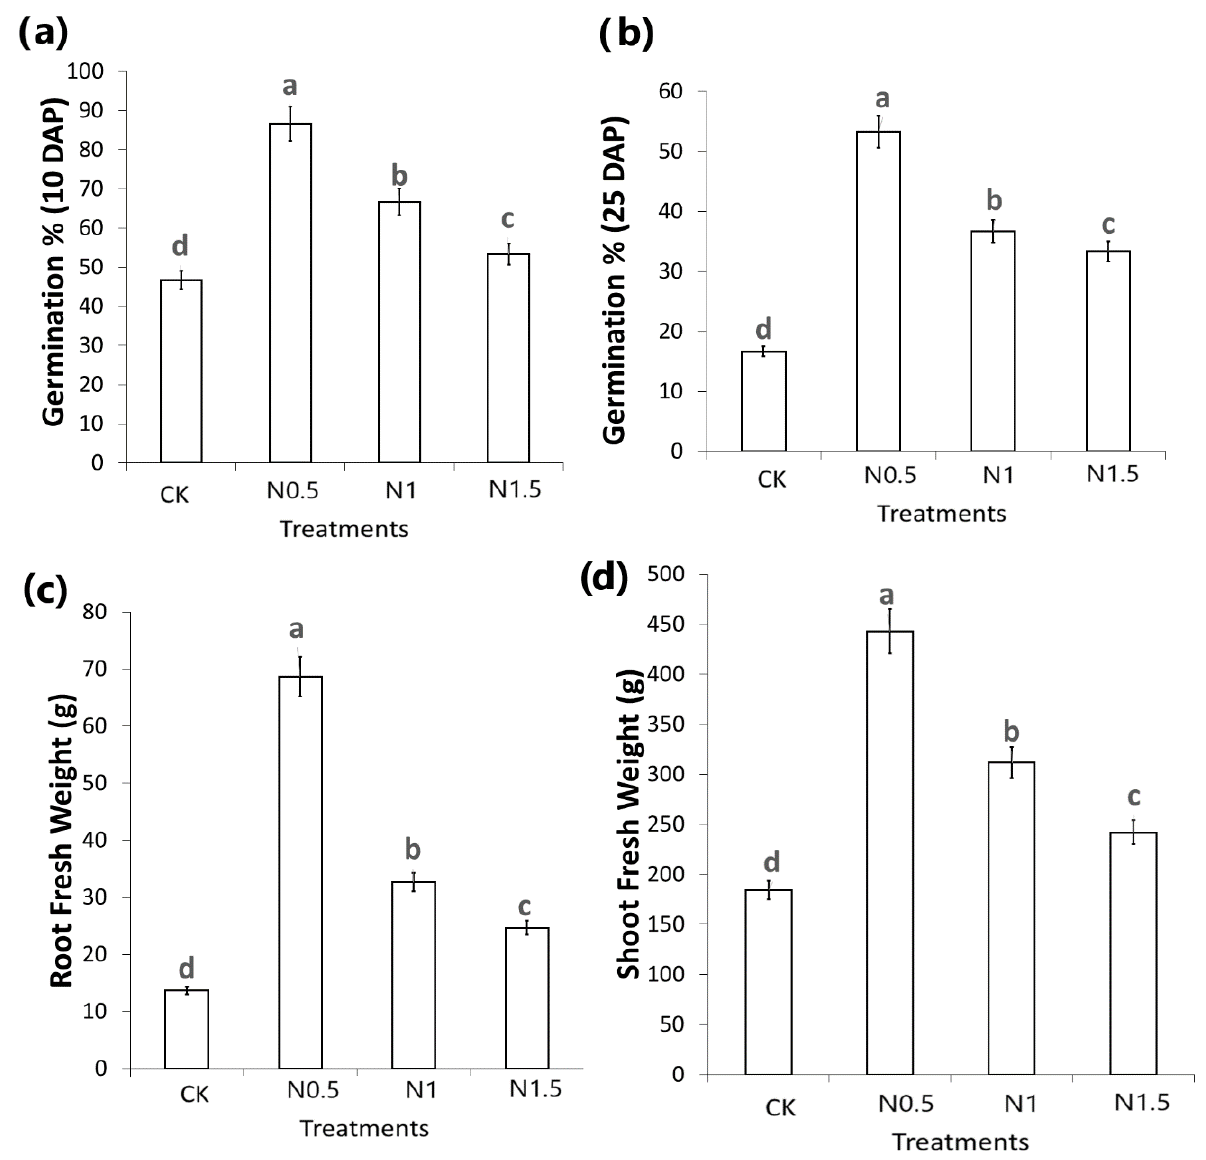
Figure 1. Mean comparisons of phenotypic traits after different NaCl treatments on the cotton seed under study: ( a ) germination percentage at 10 days after planting, ( b ) germination percentage at 25 days after planting, ( c ) root fresh weight at 25 days after planting, and ( d ) shoot fresh weight at 25 days after planting. Plots show statistical differences between treated samples. Bar plots with overlapping error bars are statistically insignificant; similarly, letters show statistical significance if samples do not share letters. CK: control: 0 h seed pretreatment NaCl, N0.5: 0.5 h seed pretreatment NaCl., N1: 1 h seed pretreatment NaCl, M12: 1.5 h seed pretreatment NaCl.